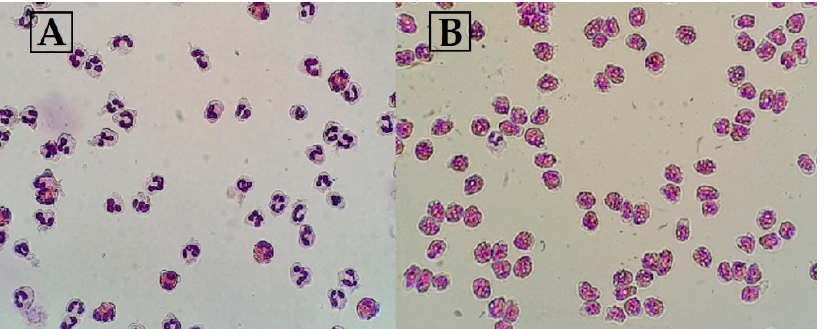
Figure 3. Eosinophil purity inspection by light microscopy after May–Grünward Giemsa staining. ( A ) Granulocytes; ( B ) eosinophils after magnetic separation.